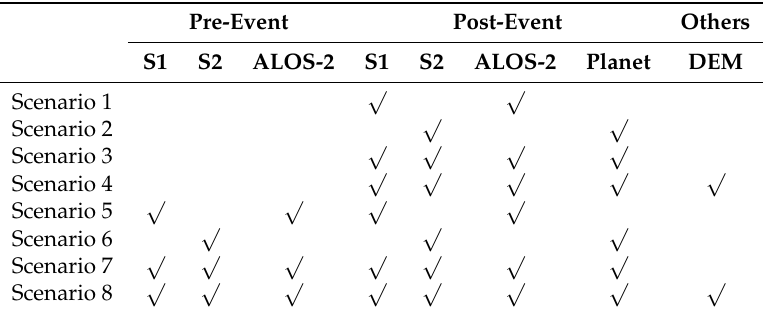
Table 3. Different combinations of datasets used in this work. Pre-Event